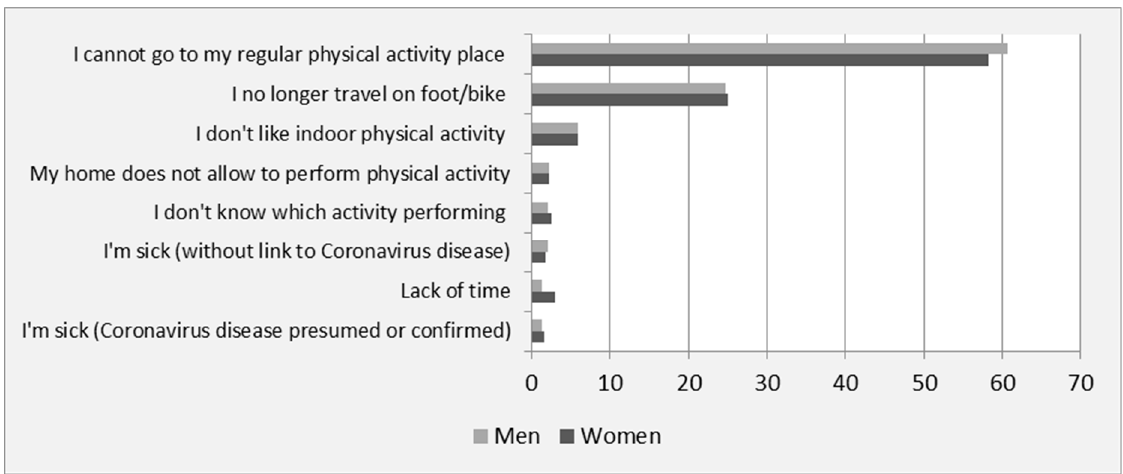
Figure 1. Main reasons (%) reported by women (n = 10,077) and men (n = 3413) to explain decreased physical activity at the beginning of the lockdown (T1).